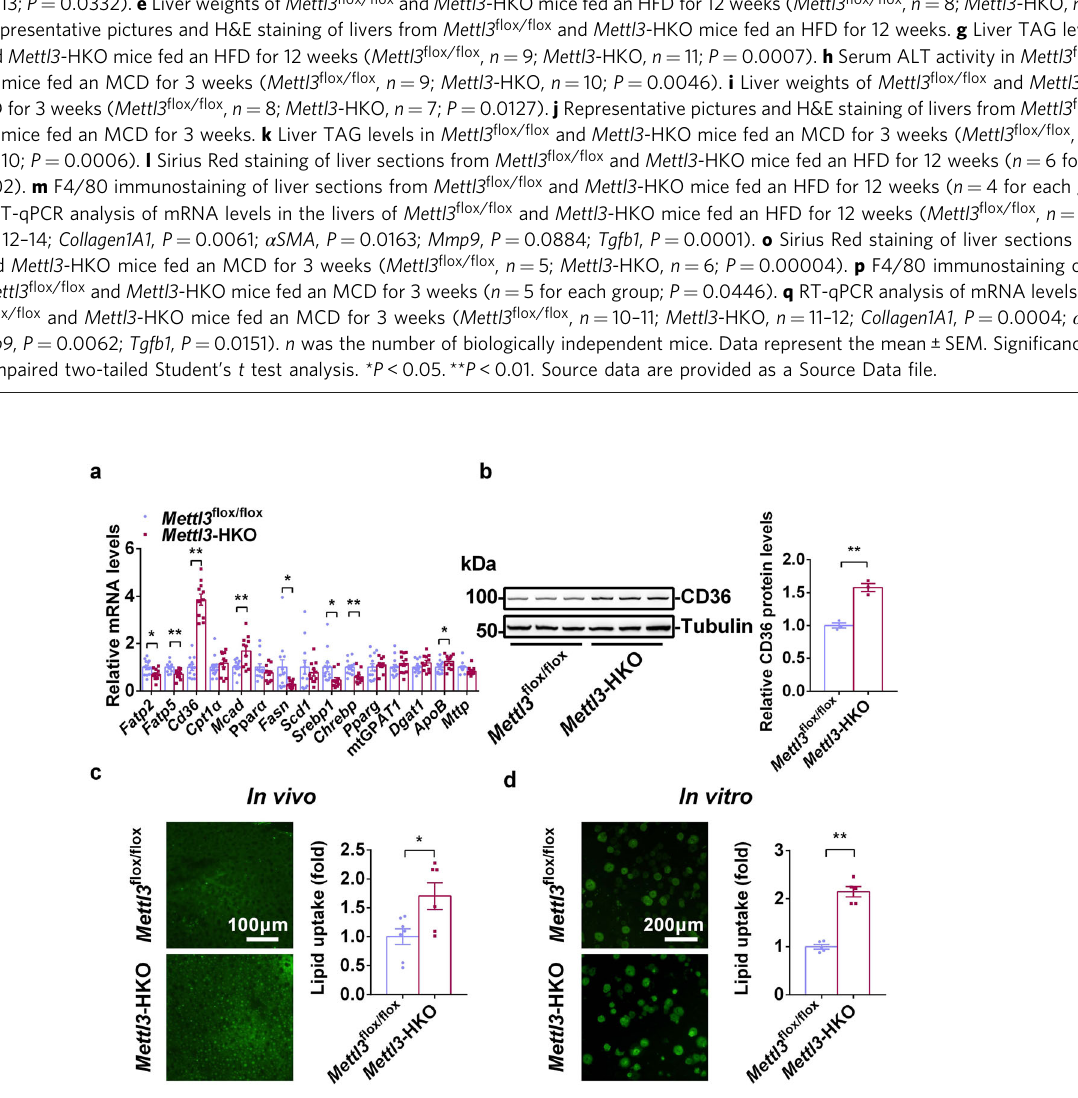
Fig. 3 Hepatic deletion of Mettl3 enhances CD36-mediated free fatty-acid uptake. a Relative mRNA levels in livers of Mettl3 fl ox/ fl ox and Mettl3- HKO mice at 8 weeks old were determined by RT-qPCR ( Mettl3 fl ox/ fl ox , n = 12 – 13; Mettl3- HKO, n = 11; Fatp2 , P = 0.0171; Fatp5 , P = 0.0029; Cd36 , P < 0.00001; Cpt1 α , P = 0.4018; Mcad , P = 0.0025; Ppar α , P = 0.2124; Fasn , P = 0.0393; Scd1 , P = 0.5119; Srebp1 , P = 0.02599; Chrebp , P = 0.00298; Pparg , P = 0.6043; mtGPAT1 , P = 0.358; Dgat1 , P = 0.1546; ApoB , P = 0.0453; Mttp , P = 0.0594). b CD36 protein levels in Mettl3 fl ox/ fl ox and Mettl3- HKO mice at 8 weeks age were measured by immunoblotting. CD36 protein levels were quanti fi ed by ImageJ and normalized to Tubulin ( n = 3 for each group; P = 0.0014). The samples were derived from the same experiment and the blots were processed in parallel. c Representative BODIPY FL C16 fl uorescence image and relative lipid uptake levels in Mettl3 fl ox/ fl ox and Mettl3- HKO mice at 8 weeks old ( Mettl3 fl ox/ fl ox , n = 7; Mettl3- HKO, n = 6; P = 0.02). d Representative BODIPY FL C16 fl uorescence image and relative lipid uptake levels in primary hepatocytes isolated from Mettl3 fl ox/ fl ox and Mettl3- HKO mice at 8 weeks old ( n = 5 for each group; P = 0.00001). n was the number of biologically independent mice or cell samples. The cell culture experiments were repeated for three times independently with similar results. Data represent the mean ± SEM. Signi fi cance was determined by unpaired two-tailed Student ’ s t test analysis. * P < 0.05. ** P < 0.01. Source data are provided as a Source Data fi